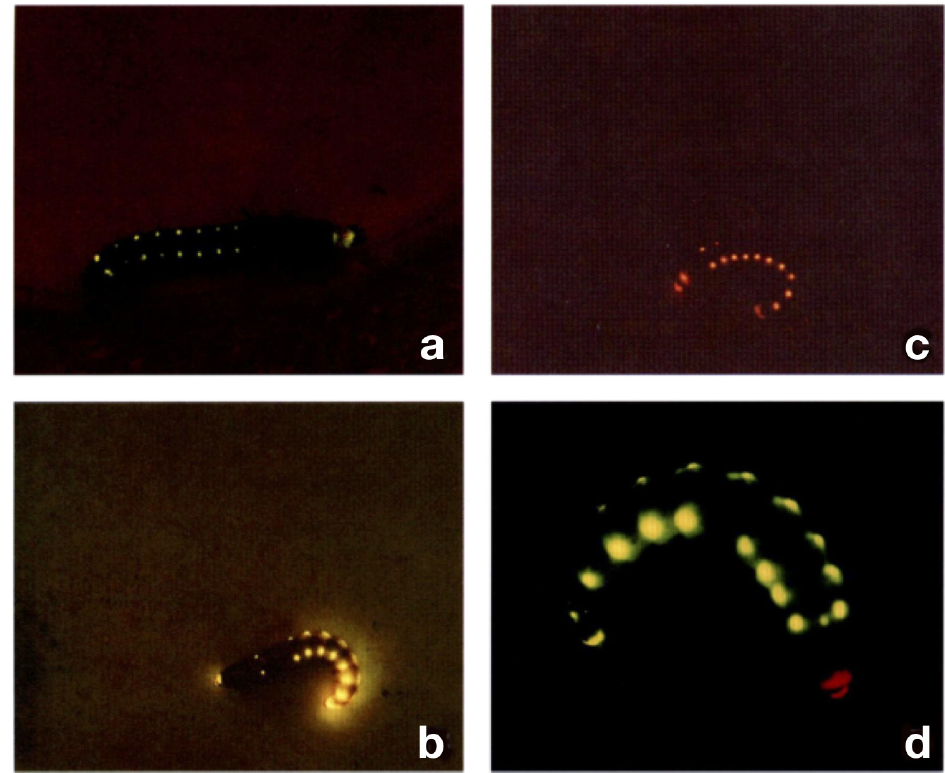
Figure 5 - Phengodids glowing: ( a ) Mature larval Brasilocerus impressicollis (2-3 cm long); ( b ) Larviform female Mastinocerus sp . (1.5-2 cm long); ( c ) Larval Mastinocerus sp 1